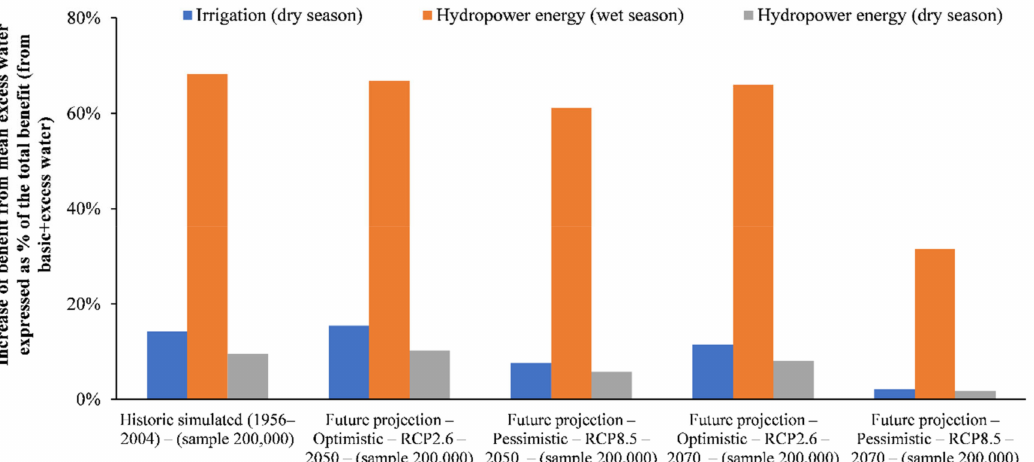
Figure 10. Irrigation benefit together with the hydropower benefit for the wet (November to April) and dry (May to October) months, for the current period and for the near and far